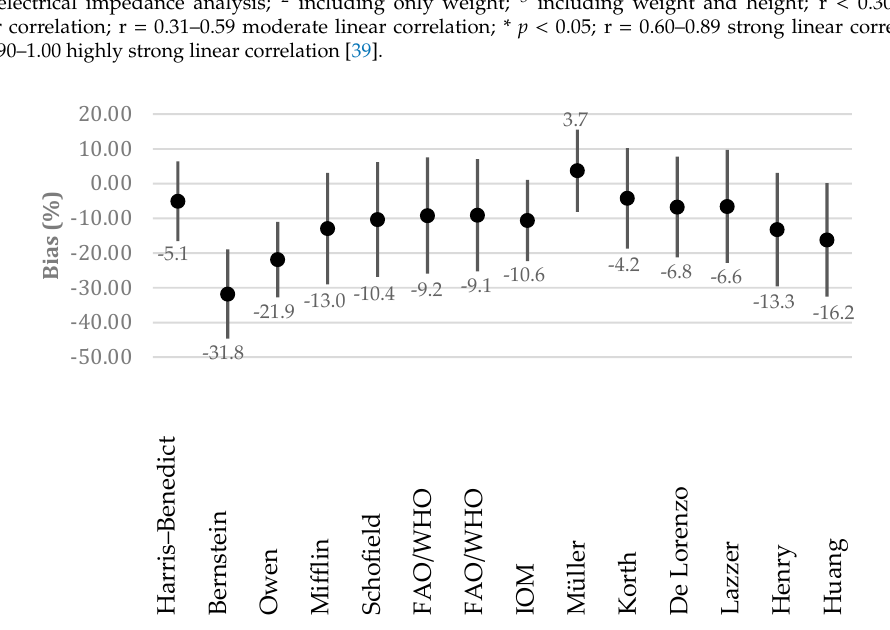
Table 4. Means and standard deviations (SD) of mean differences of the estimated and predicted REE.